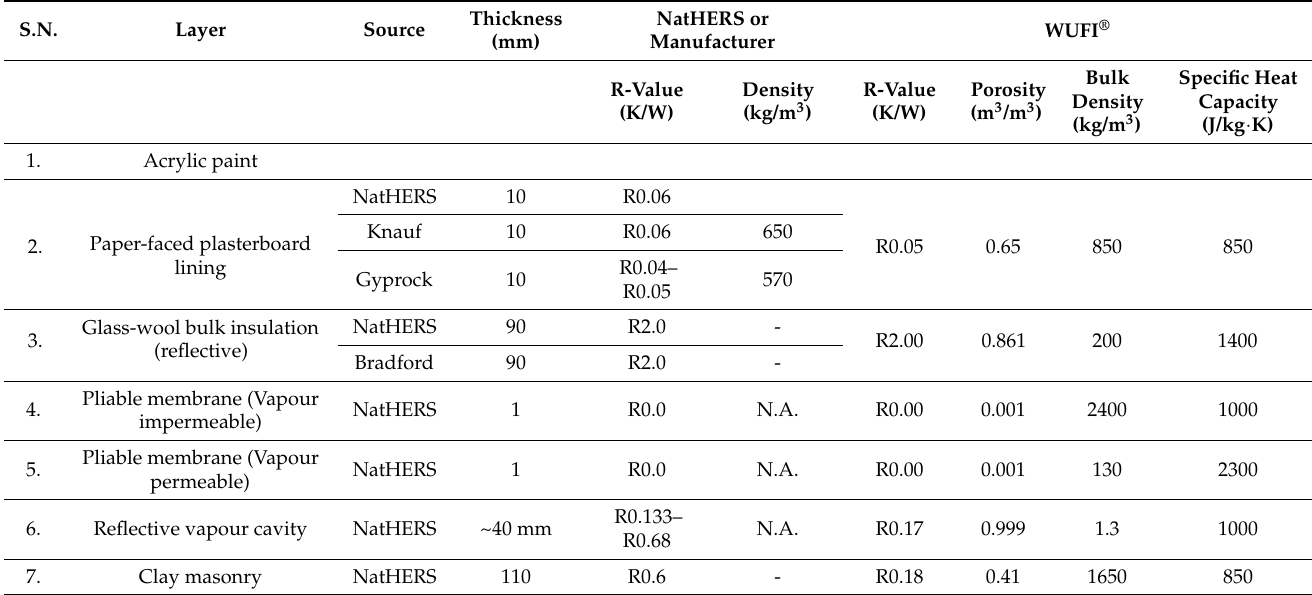
Table 4. Data showing specifications of the timber-framed clay masonry veneer wall system